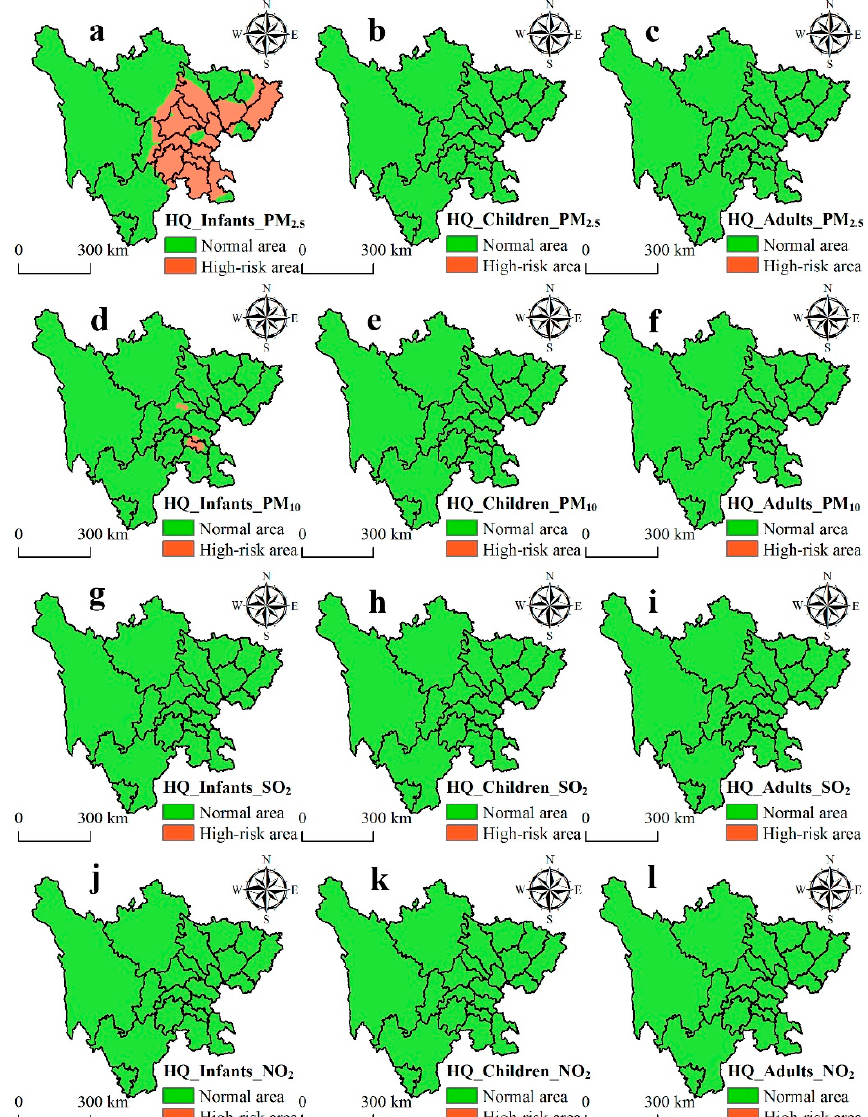
Figure 4. Risk assessment of chronic exposure to main air pollutants in Sichuan. ( a – c ) / ( d – f ) / ( g – i ) / ( j – l ) represent hazard quotient for infants, children, and adults for PM 2.5 (HQ_Infants_PM 2.5 , HQ_Children_PM 2.5 , and HQ_Adults_PM 2.5 ) / PM 10 (HQ_Infants_PM 10 , HQ_Children_PM 10 , and HQ_Adults_PM 10 ) / SO 2 (HQ_Infants_SO 2 , HQ_Children_SO 2 , and HQ_Adults_SO 2 ) / NO 2 (HQ_Infants_NO 2 , HQ_Children_NO 2 , and HQ_Adults_NO 2 ),